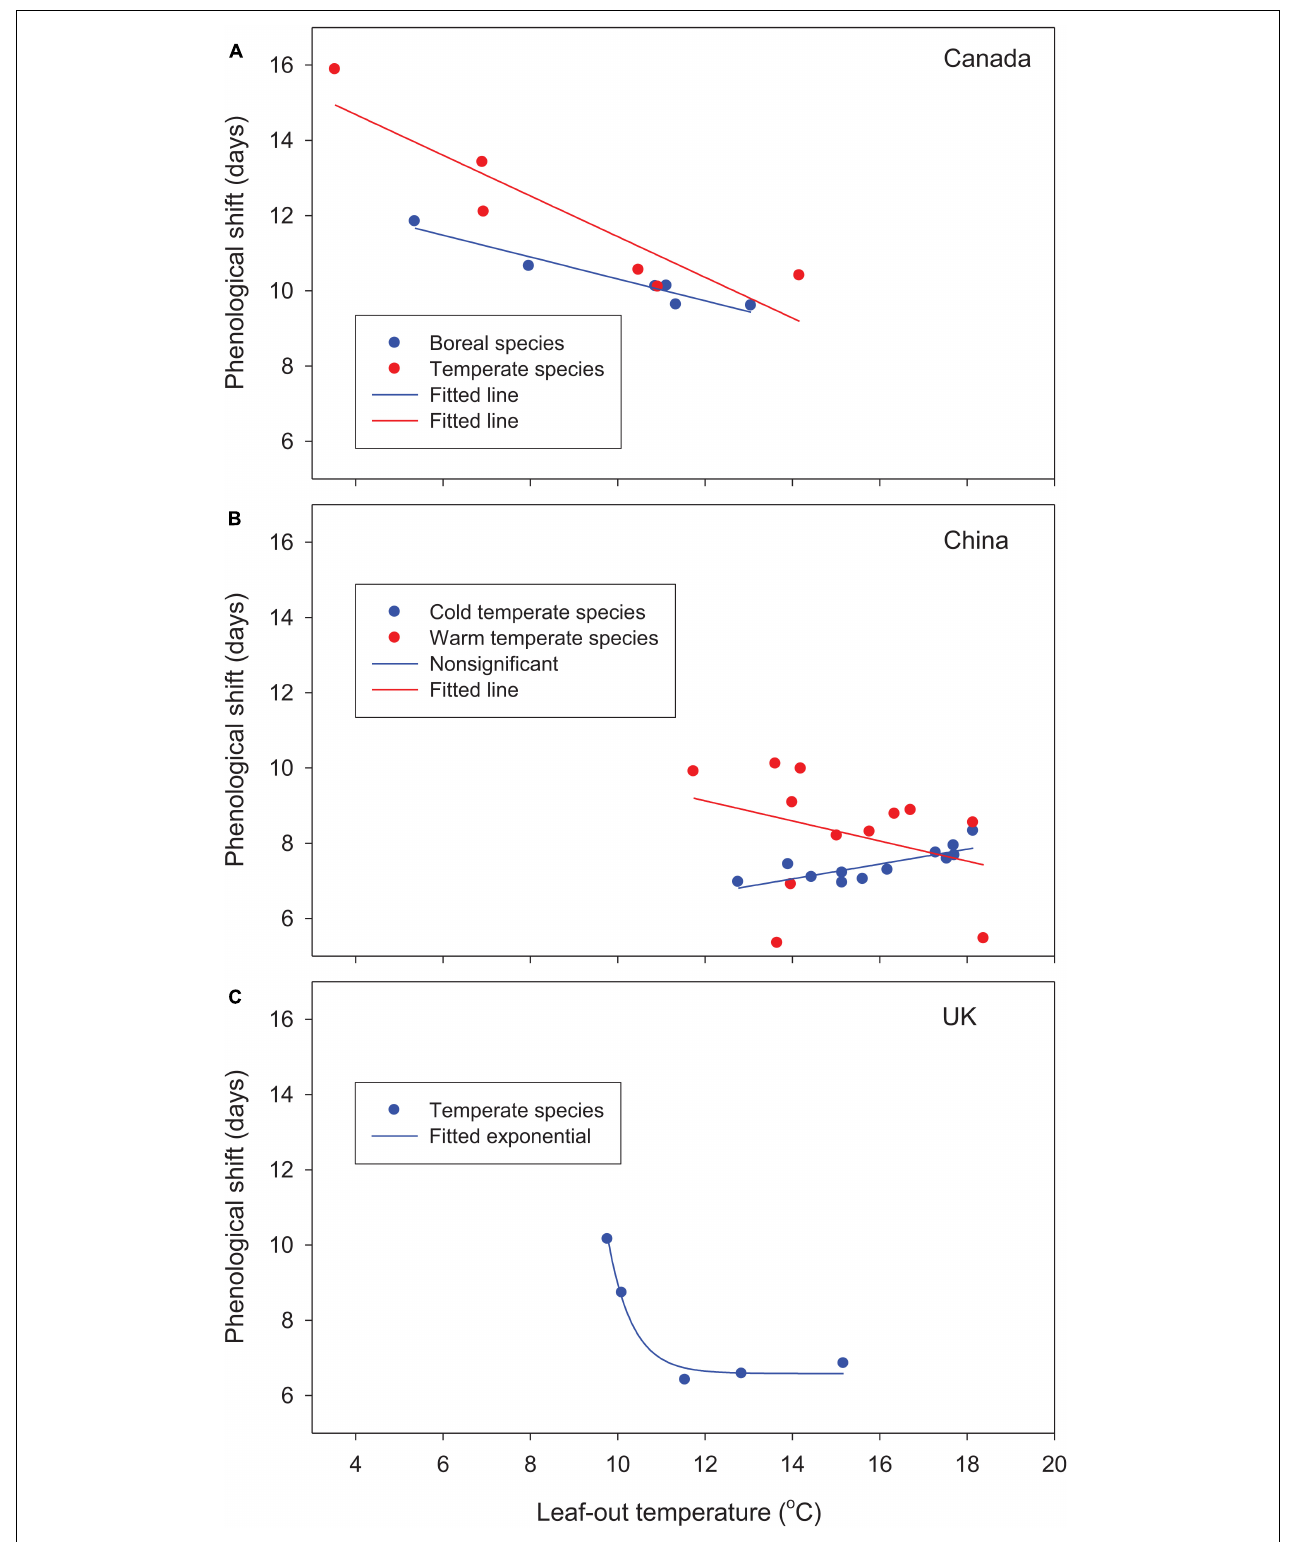
FIGURE 3 | Relationships between phenological shifts of woody species from the 1981–2010 baseline to future warmer (2 ◦ C uniform warming) climates and leaf-out temperatures (average temperatures during phenological shifts) for (A) Canada, (B) China, and (C) the United Kingdom. Values are averaged by species/species groups over 30 years and 9–12 locations under baseline and future warmer